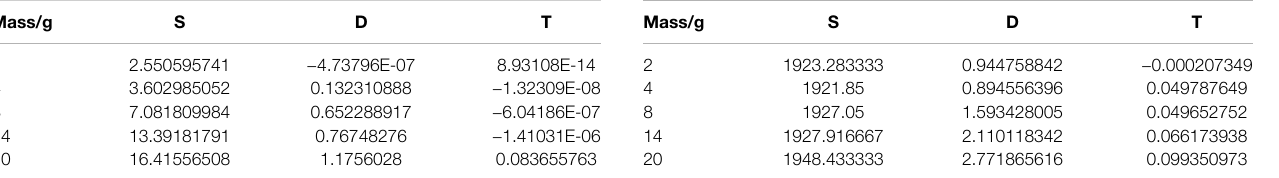
TABLE 8 | Sample 1